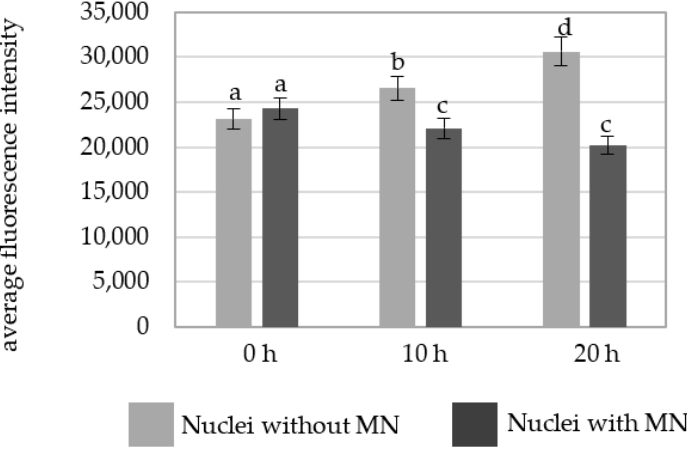
Figure 7. A comparison of the average fluorescence intensity of Alexa 488 that was used to detect 5 mC in the B. distachyon nuclei with and nuclei without micronuclei in the MNU-treated cells at different posttreatment times. Fluorescence of Alexa 488 was measured in relative units. ANOVA followed by Tukey HSD test, p < 0.05; mean ± SD, statistically significant differences are indicated by different letters.